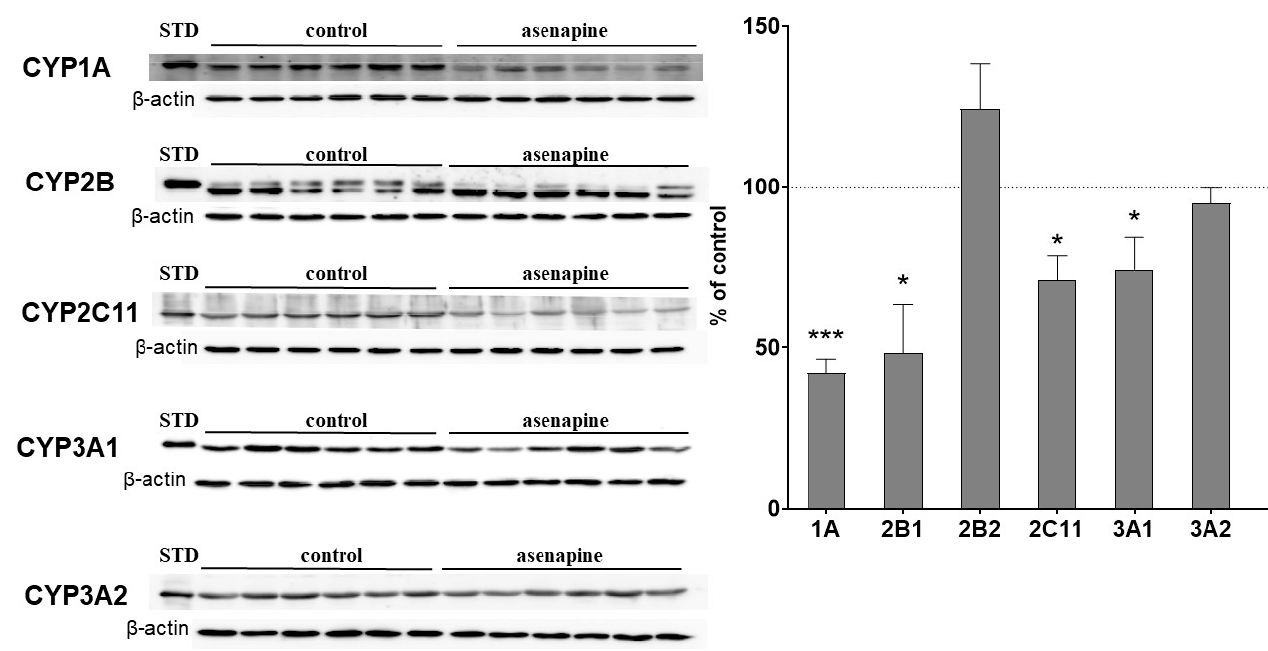
Figure 2. The effect of chronic asenapine treatment on the protein level of CYP1A, CYP2B1, CYP2B2, CYP2C11, CYP3A1 and CYP3A2 enzymes in rat liver microsomes. Microsomal proteins, 10 µ g, were subjected to the Western immunoblot analysis. The results are presented as representative blots from six (for the control and for asenapine treatment) separate rats per treatment. The data are expressed as the mean ± SEM ( n = 12). Statistical significance was assessed by Student’s t -test and marked as * p < 0.05, *** p < 0.001, compared to the control.